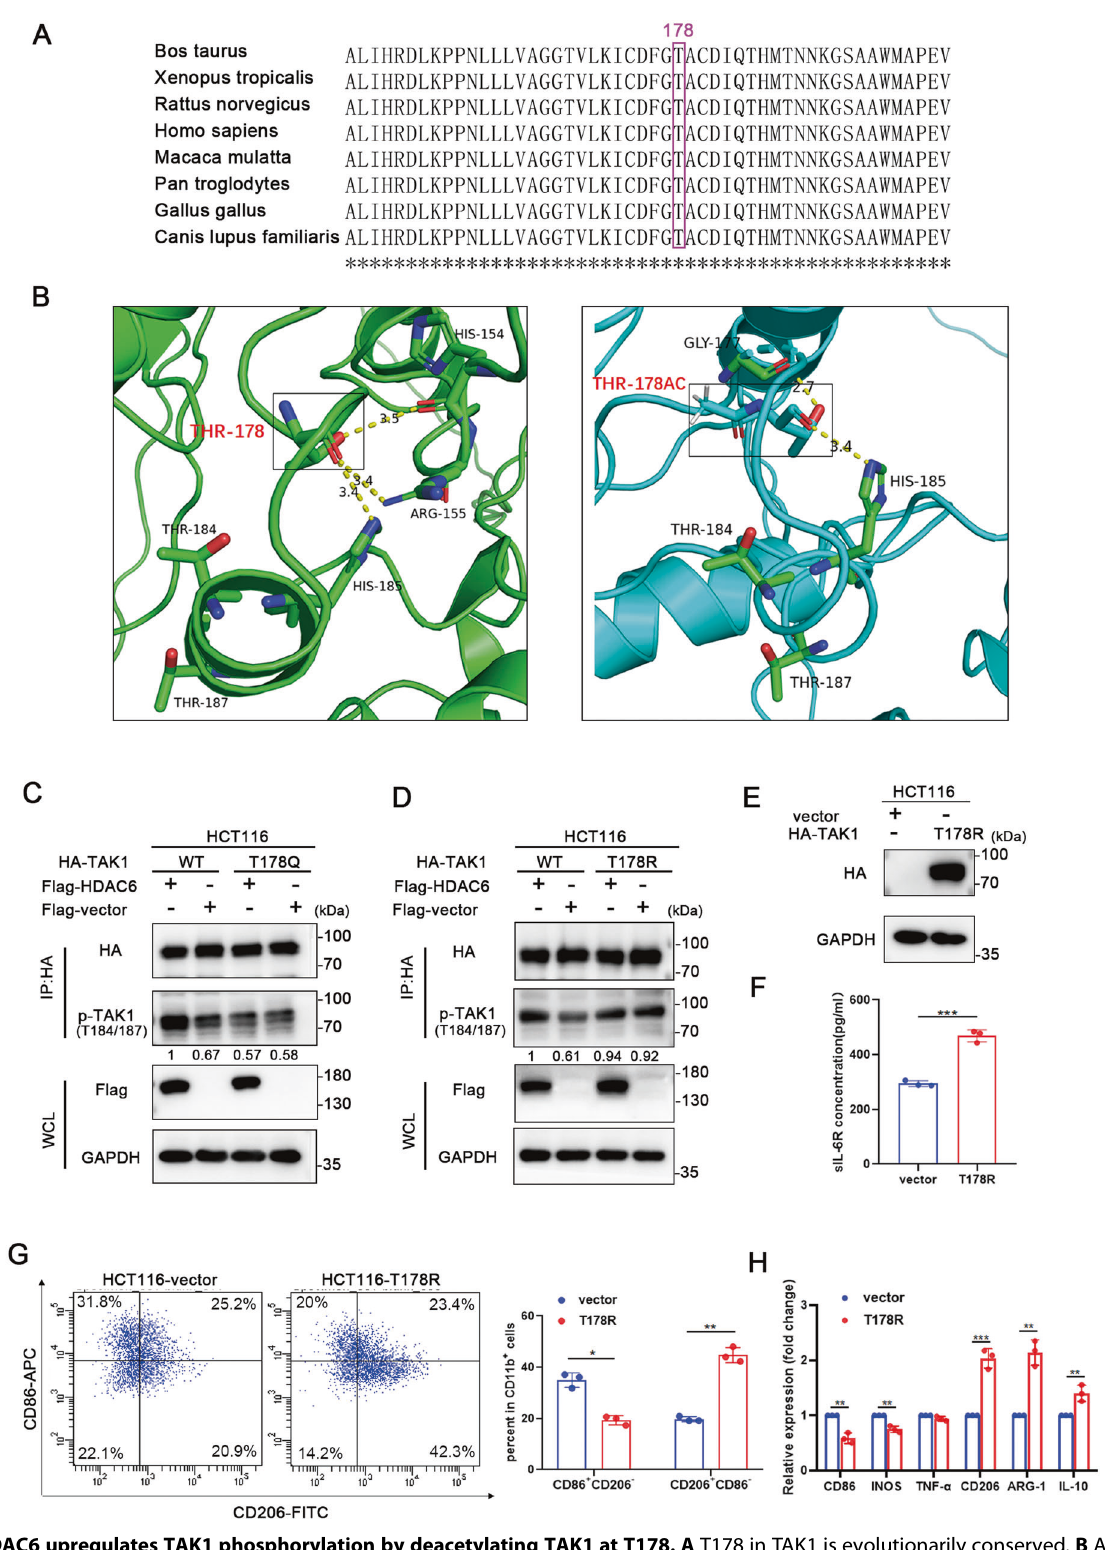
Fig. 6 HDAC6 upregulates TAK1 phosphorylation by deacetylating TAK1 at T178. A T178 in TAK1 is evolutionarily conserved. B Acetylation of the T178 residue of TAK1 as mimicked (left, wild type TAK1; right, T178Ac TAK1). The related sites are marked in the picture. C , D HA-tagged TAK1 was coexpressed with the empty vector or Flag-HDAC6, and an HA-tagged TAK1 acetylation mimic mutant (left, T178Q) or deacetylation mimic mutant (right, T178R) was coexpressed with the empty vector or Flag-HDAC6. After the transfection of HCT116 cells, total cell lysates were immunoprecipitated with an anti-HA antibody, and the precipitated proteins were probed with a p-TAK1 (T184/187) antibody. E HA- tagged TAK1-T178R or vector was overexpressed in HCT116 cells. F Analysis of sIL-6R levels in the cell media by ELISA. G Flow cytometry assessed the surface expression of CD11b, CD86 and CD206 of cocultured macrophages in the indicated groups. H QPCR detected the expression of M1 and M2 polarization related genes of cocultured macrophages in the indicated groups. Data were shown as the mean ± SD of three independent experiments, * P < 0.05; ** P < 0.01; *** P < 0.001. Cell Death and Disease (2022)